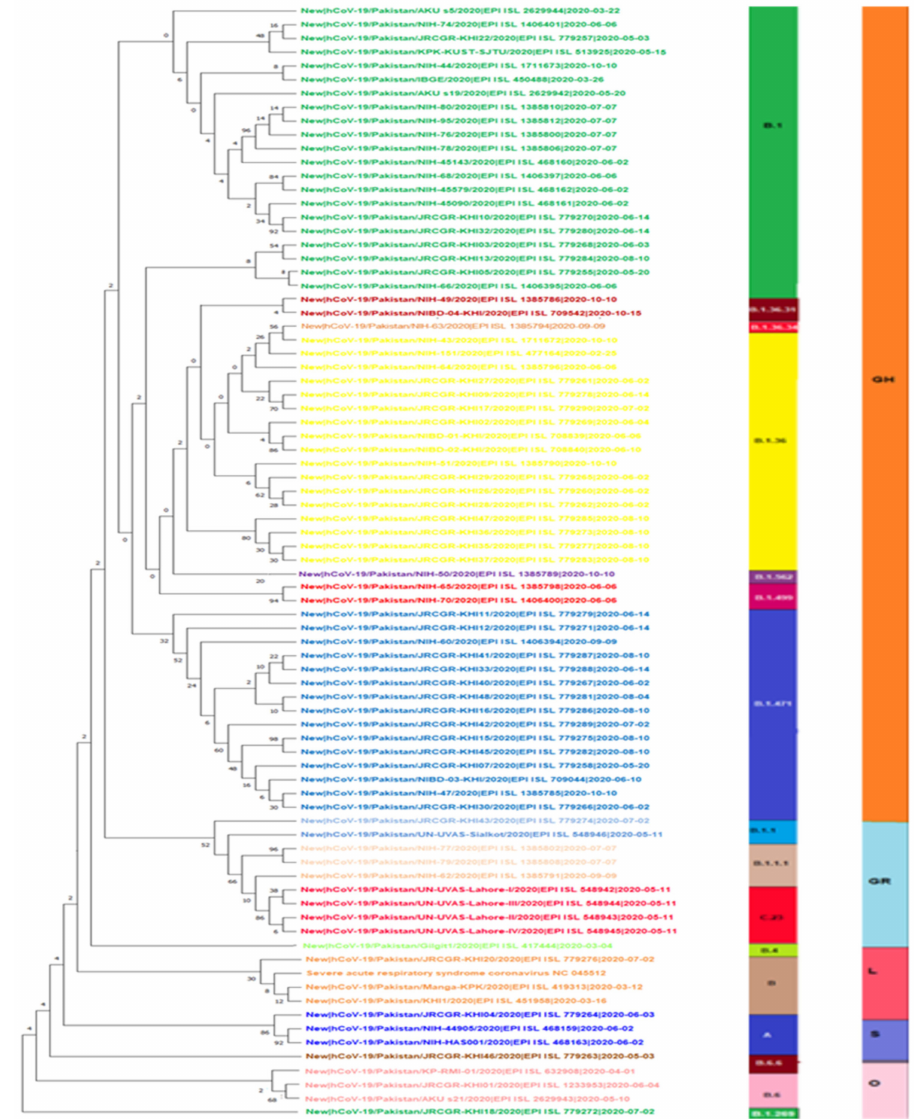
Figure 9. Maximum Likelihood phylogenetic tree of SARS-CoV-2 genome during first wave of infection representing 16 (A, B, B.1.1, B.1.1.1, B.1.260, B.1.36, B.1.36.31, B.1.36.34, B.1.471, B.1.499, B.1.562, B.4, B.6, B.6.6, C23) lineages of 5 clades (GH, GR, L, S, O) in first